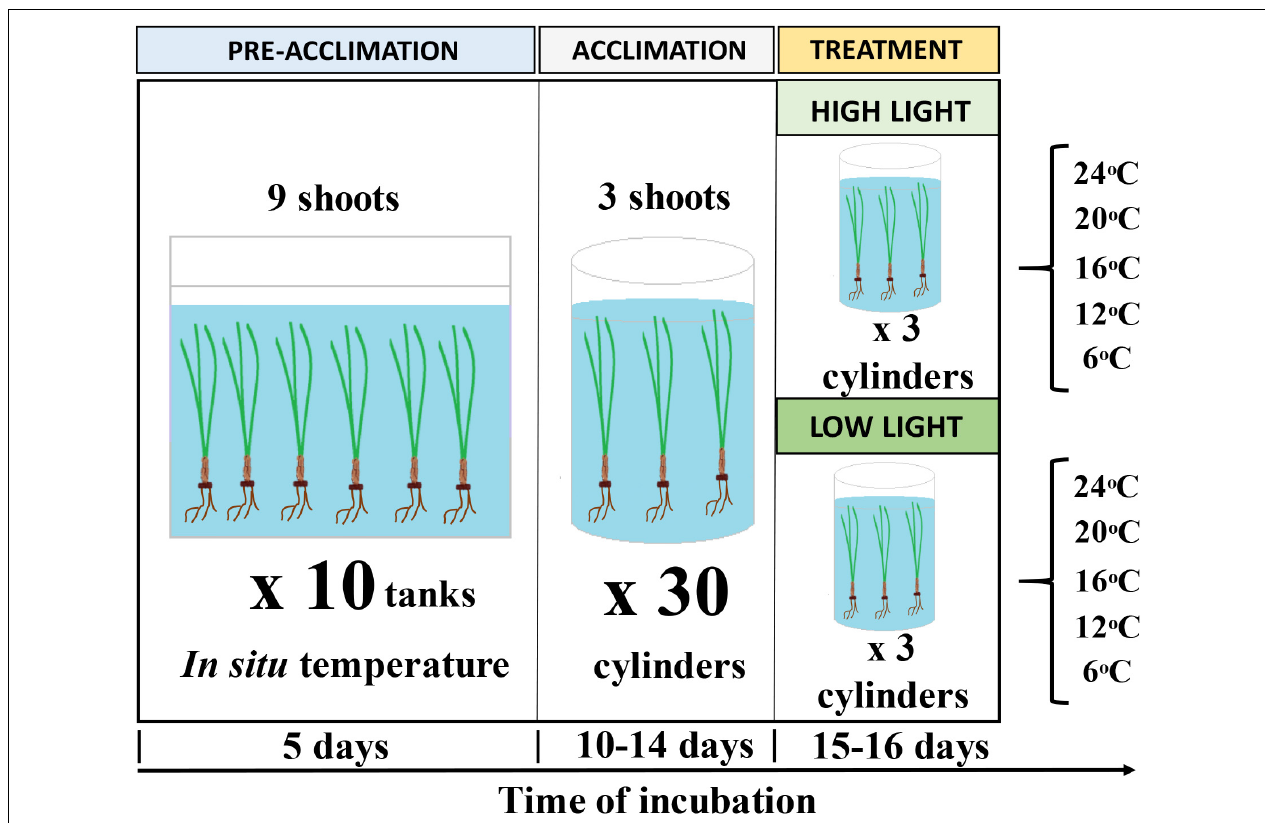
FIGURE 2 | Schematic of the experimental design. Plants of Zostera marina incubated at high (180 µ mol photons m − 2 s − 1 ) or low 60 µ mol photons m − 2 s − 1 ) light and 5 temperatures (6, 12, 16, 20 and 24 ◦ C). Three cylinders ( n = 3) containing three seagrass shoots were incubated in each treatment.